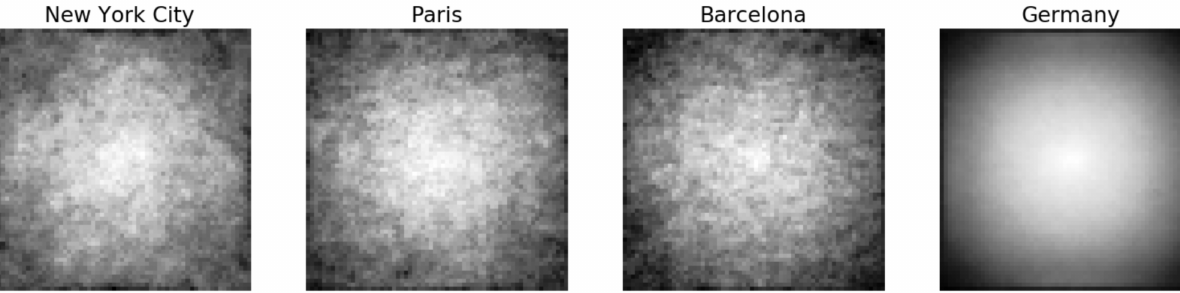
Figure 4. The average image pixels over the four classes used in the experiment for each locational pixel. Brighter pixels indicate higher